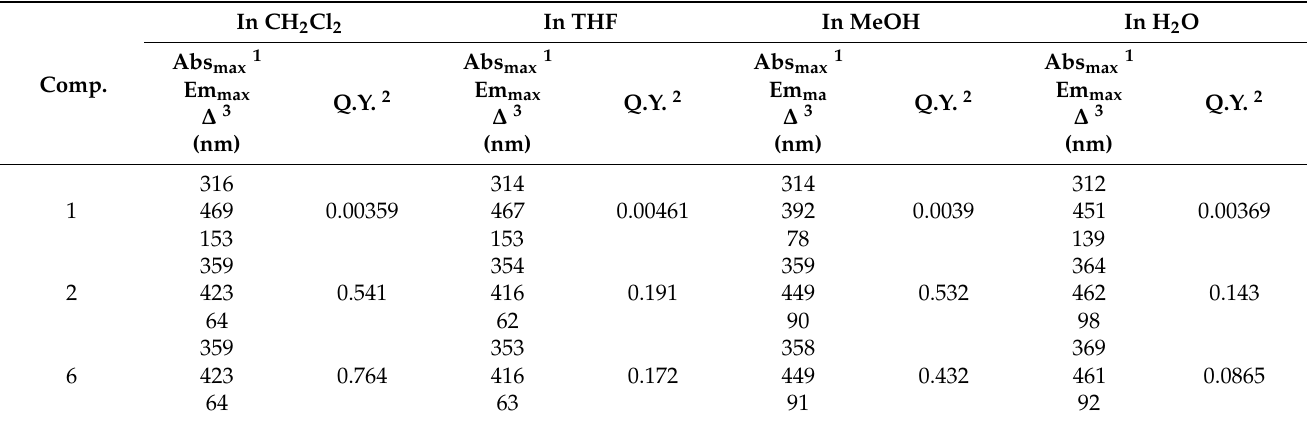
Figure 4. ( a ) Fluorescence spectrum of 2 , in CH 2 Cl 2 , THF, MeOH, or H 2 O (2 µ M). ( b ) Fluorescence spectrum of 6 , in CH 2 Cl 2 , THF, MeOH, or H 2 O (2 µ M). Table 3. Fluorescence properties for PPAR γ ligands 1 , 2 , and 6